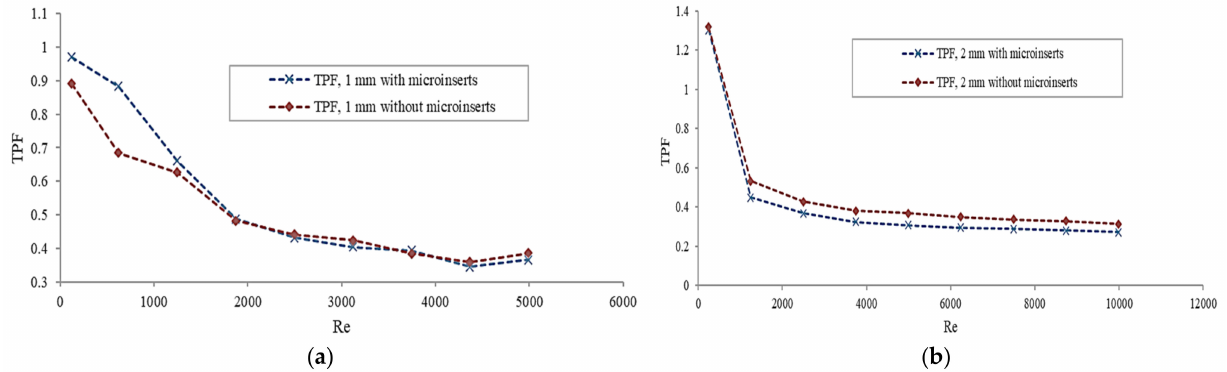
Figure 8. Variation in TPF with Reynolds number.